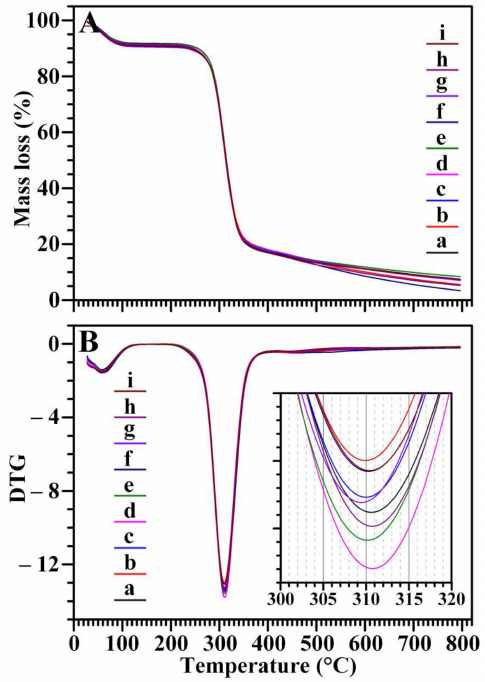
Figure 8. TGA curves ( A ) and DTG curves ( B ) of starches from variety 3113 ( a ), Benlizi ( b ), Dahongpao ( c ), Erqingzao ( d ), Heishanzhai 7 ( e ), Mi 5 ( f ), Mi 6 ( g ), Yangguang ( h ), and Yanshanhong ( i